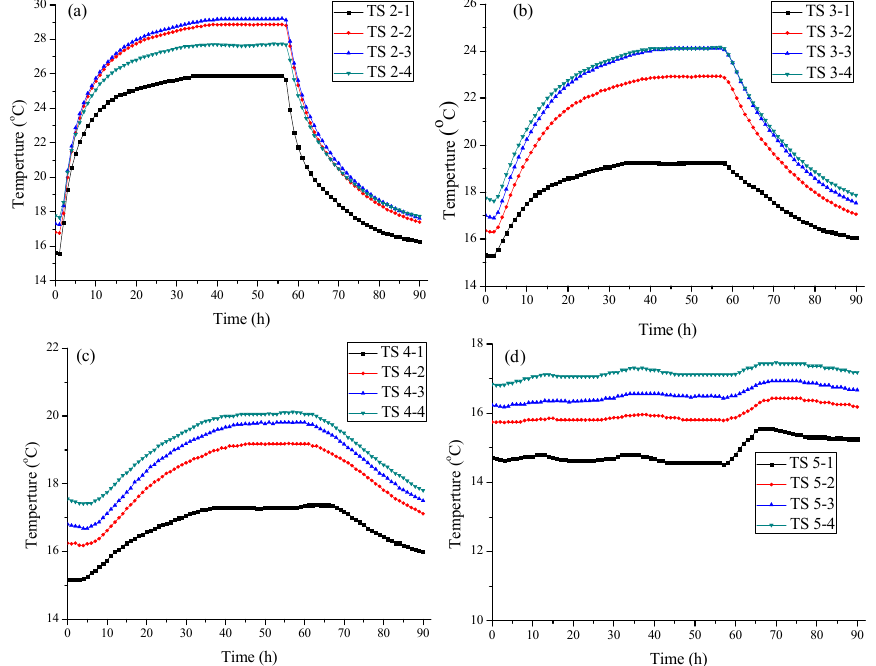
Figure 8. Time-dependent temperature curves of TSs of different distances to UT along each row in the fluid circulation of 50 °C: ( a ) Array 1 TSs; ( b ) Array 2 TSs; ( c ) Array 3 TSs; ( d ) Array 4 TSs.